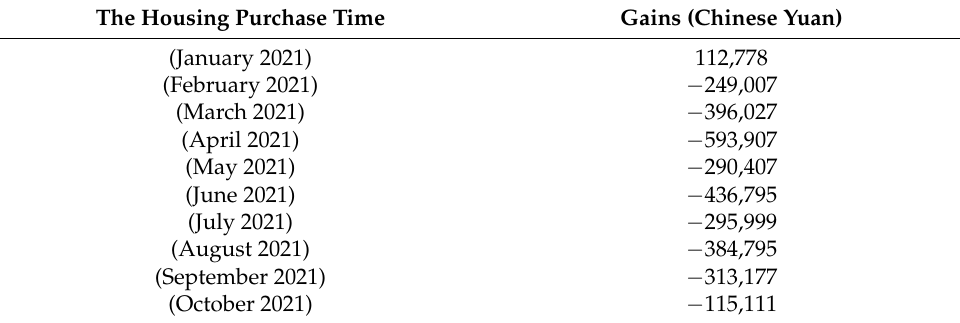
Table 5. Profit and loss of herding investors over time. The Housing Purchase